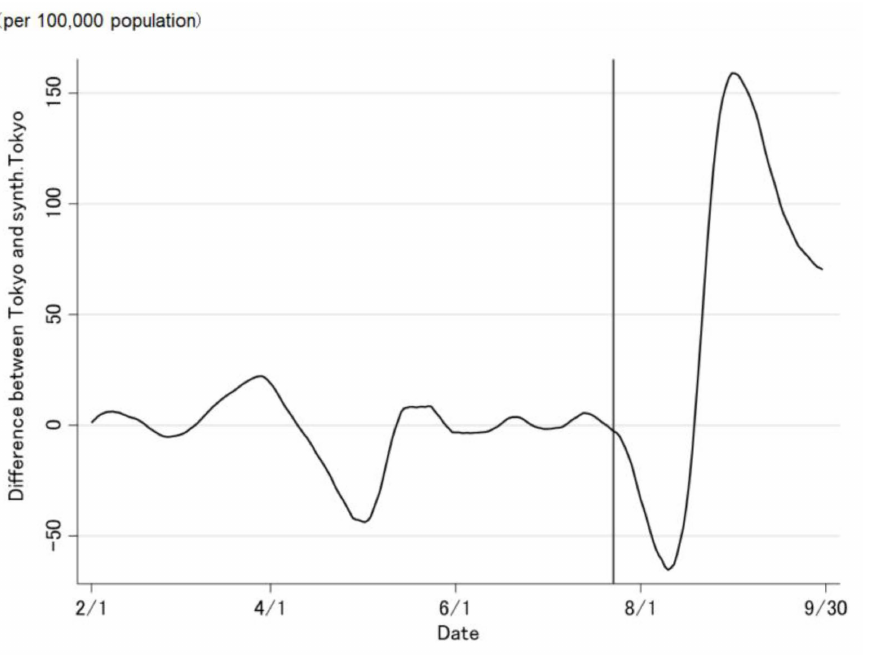
Figure 9. Difference in the cumulative daily number of newly confirmed COVID-19 cases between Tokyo and synthetic Tokyo, determined using regression